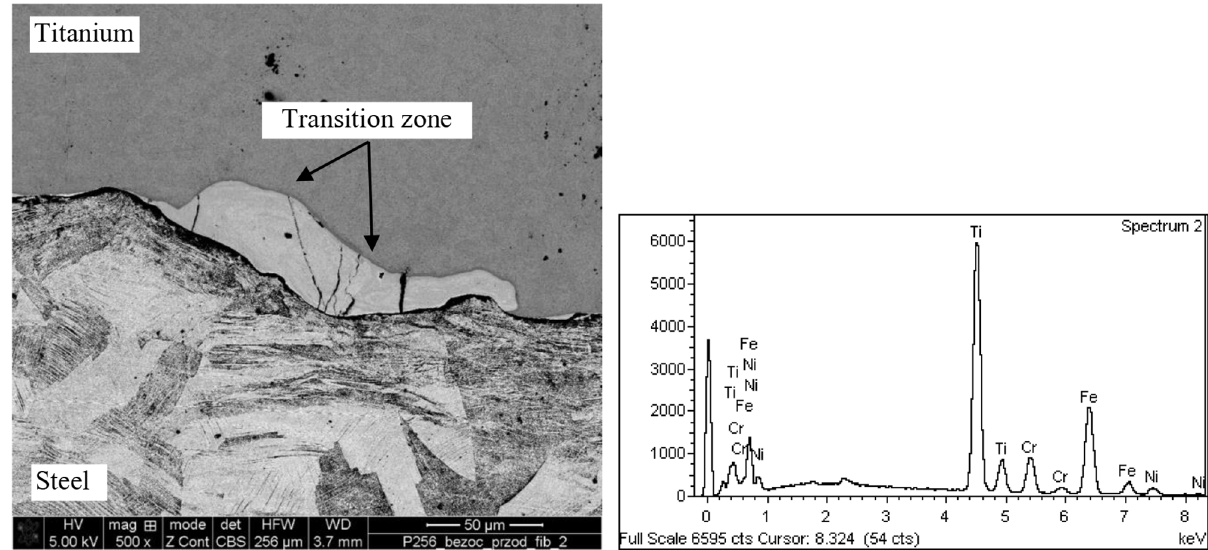
Fig. 7. SEM observation and EDS analysis of transition zone.